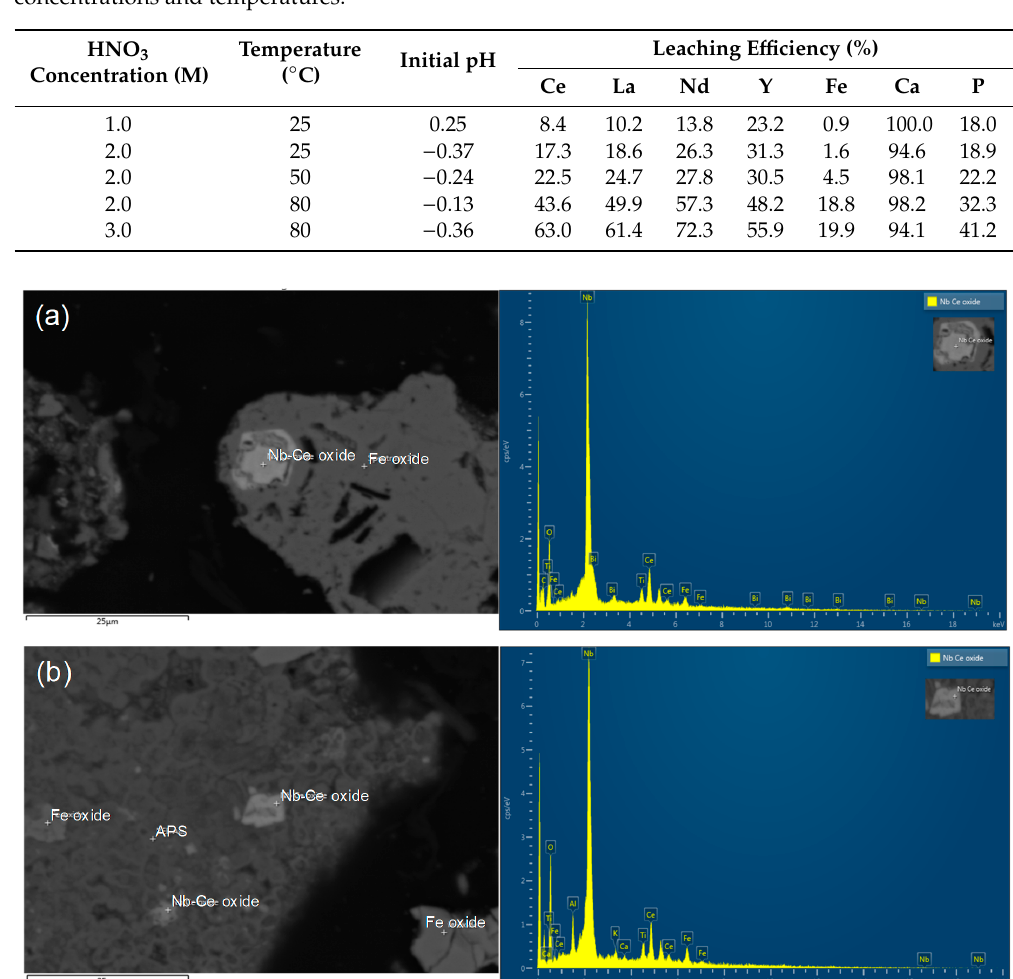
Figure 7. SEM-EDX analysis of preliminary leaching residue (leached at 3.0 M HNO 3 and 80 °C): ( a ) Fe oxide grain trapping Nb–Ce oxide; ( b ) micro-breccia of alumino-phosphate-sulfate (APS) bearing Fe oxide and Nb–Ce oxide.